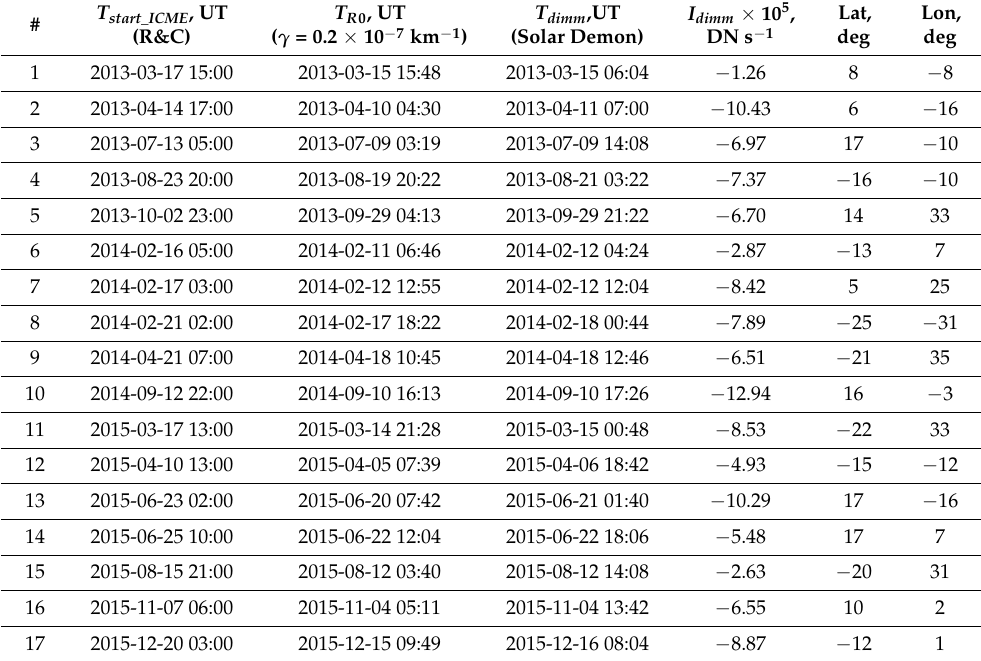
Table 5. Identification of solar origins for the selected ICMEs in the period 2013–2015 by